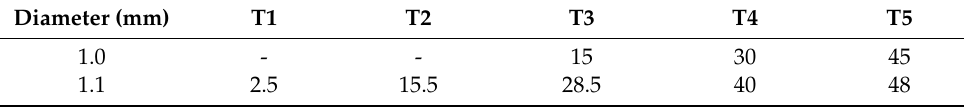
Table 2. Coordinates of the